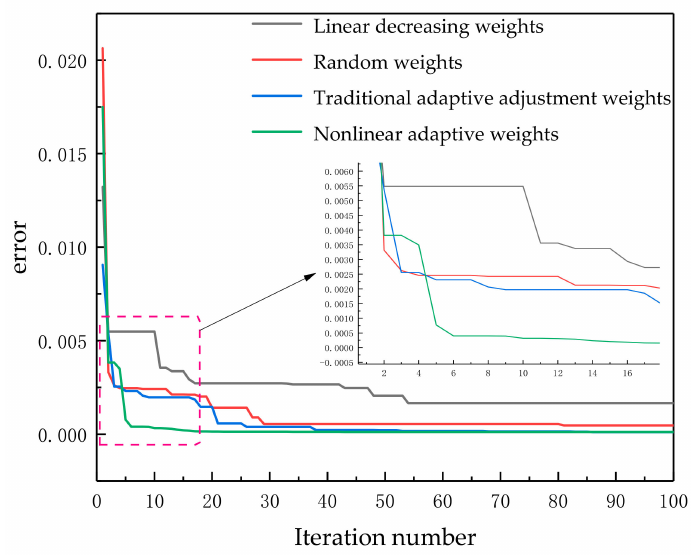
Figure 8. Comparison of Optimal Search by PSO Algorithm Based on weight adjustment